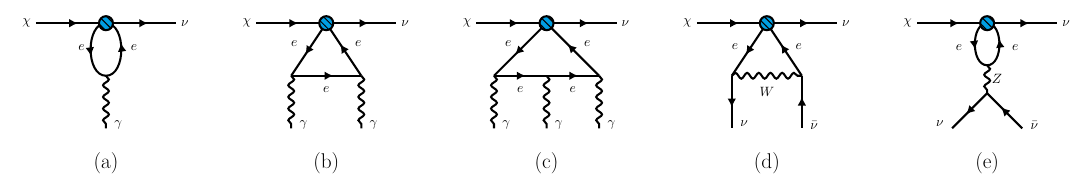
Figure 5 . The representative Feynman diagrams contributing to the DM visible decays χ → ν + γ (s) as well as the invisible decay χ → 3 ν . The blue vertex is the DM absorption operator while the others are SM interactions.